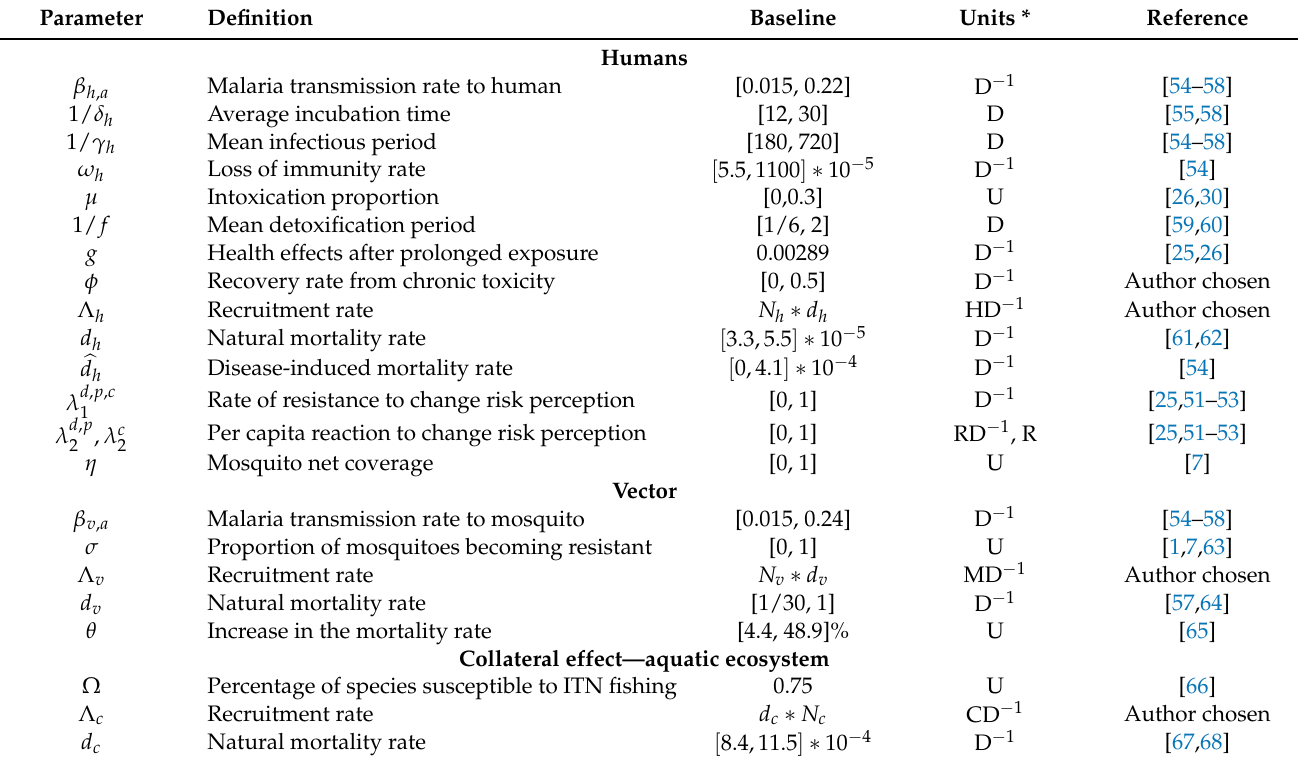
Table 2. Description of parameters and parameter value ranges for the model given in system (5) and used in the